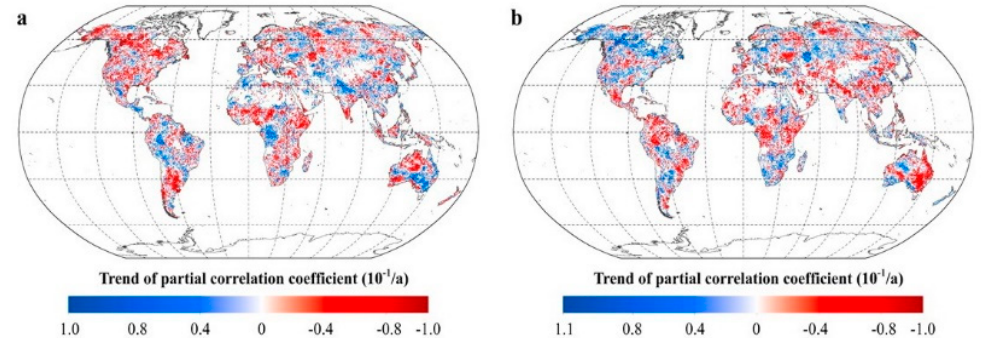
Figure 6. The response of vegetation greenness to the diurnal temperature. ( a . spatial distribution of the temporal trend of the partial coefficients between mean annual NDVI and T max . b . spatial distribution of the temporal trend of the partial coefficients between mean annual NDVI and T min . Supplementary Table S1).